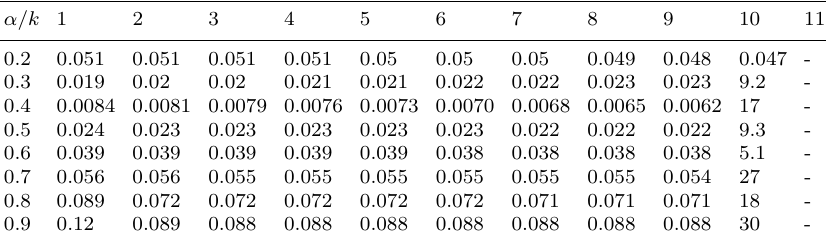
Table 3. The values δ V (the scheme B ) for various α and β = 0 . 1 kβ nec ( α,M 0 ) and M 0 =